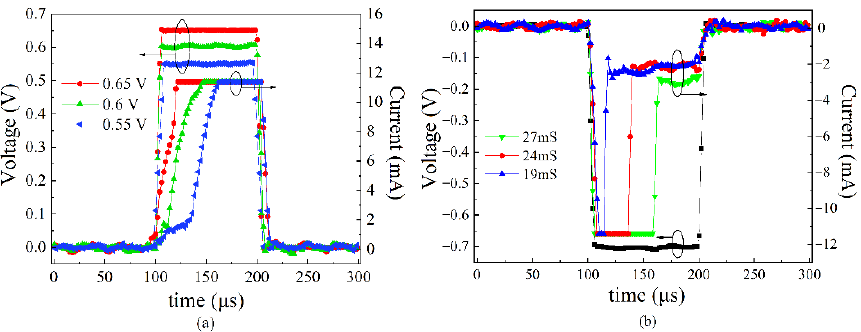
Figure 4. Dynamic current response typical of a 100 μs pulse width, and square-waveform voltage pulse (rise time = 5000 ns). ( a ) Varying amplitude by 0.55 V, 0.6 V, and 0.65 V, and fixed initial conductance in the set process. ( b ) Varying initial conductance and fixed −0.7 V amplitude in the reset process. The current range was set to 10 mA to protect the RRAM devices from permanently breaking down during the transient